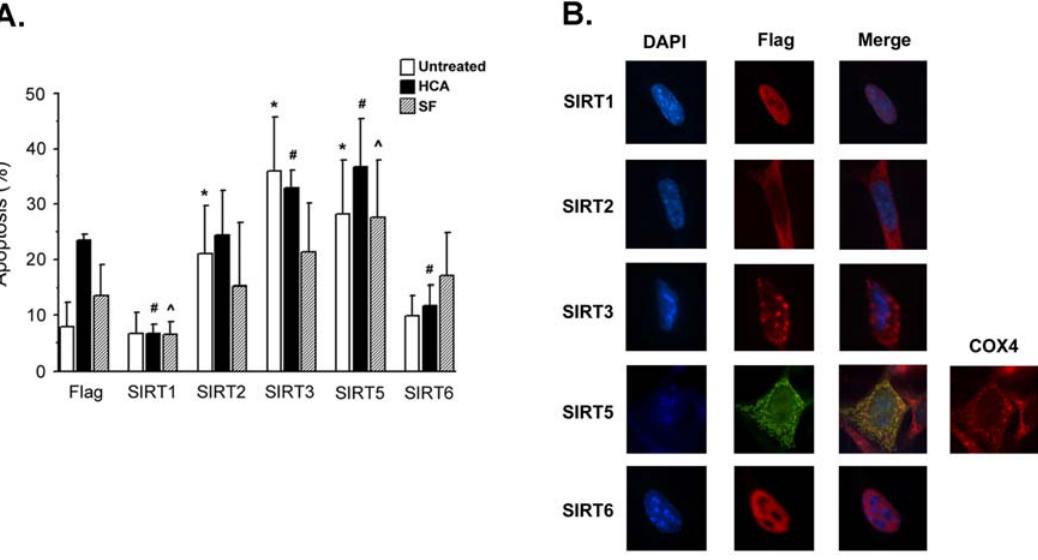
Figure 5. Forced sirtuin expression in the HT-22 cells. (A) Effect of sirtuin expression on HT-22 cell survival. Sirtuin expression levels were enhanced in HT-22 neuroblastoma cells via transfection with mammalian expression plasmids. HT-22 cells were treated 24 hours following transfection with normal growth medium (untreated), 1 mM HCA or Serum-free (SF) medium for 24 hours. The viability of transfected cells was determined using a TUNEL assay. The mean of 5 experiments were taken (* indicates p , .05 compared with Flag untreated sample; # indicates p , .05 compared with Flag HCA sample; ^ indicates p , .05 compared with Flag SF sample). (B) Subcellular localization of exogenous SIRT1, SIRT2, SIRT3, SIRT5 and SIRT6 in HT-22 cells. HT-22 cells were transfected with SIRT-Flag constructs and immunocytochemistry performed using a Flag antibody. DAPI staining was used to visualize nuclei/chromatin. SIRT5 shows colocalization with the mitochondrial protein Cox4.